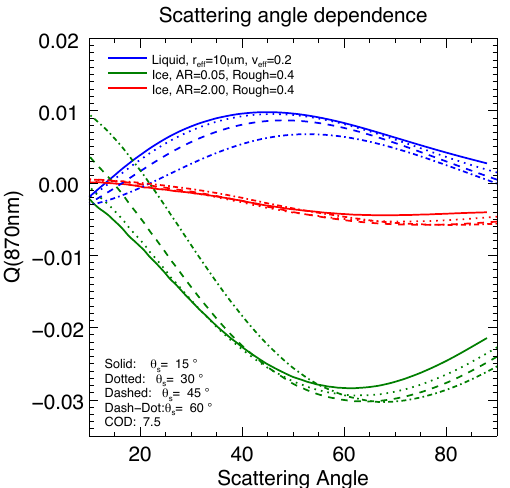
Figure 7. Spectral dependence of simulated Q as a function of cloud optical depth. The linear polarization of liquid clouds ( r eff = 20µm, v eff = 0 . 2 shown here) changes significantly for different wavelengths. Q is smaller as wavelength decreases, and the short- est wavelength, 440nm, is negative. Ice clouds are more uniform for the various simulated spectral channels. Like liquid clouds, ice clouds (AR = 20, roughness = 0 . 4 shown here) have more negative values of Q as wavelength is